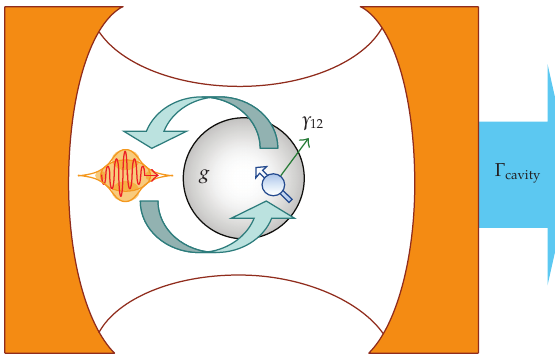
Figure 1: Storage, exchange and traveling qubits inside a quantum network